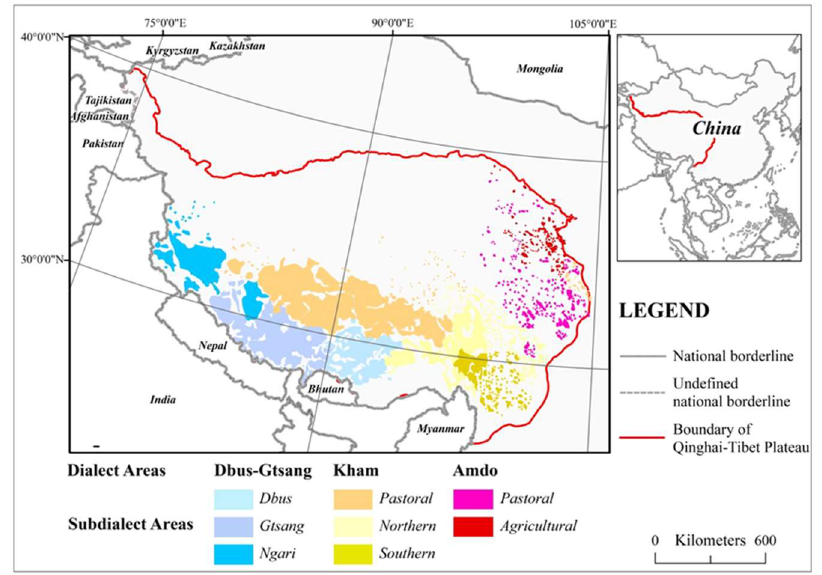
Figure 1. Location of the study area. (The Qinghai–Tibet Plateau of the Chinese part is located in southwestern China. The distribution map of the Tibetan dialect areas and subdialect areas was drawn by the Chinese Academy of Social Sciences in 2012).